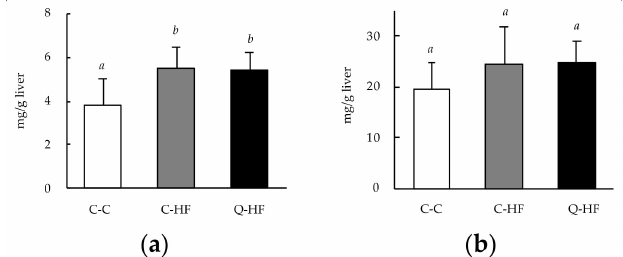
Figure 6. Effects of maternal quercetin consumption on hepatic total cholesterol and triglycerides. Male progeny of dams fed a control diet (C) or a diet containing 1.0% quercetin (Q) were divided into three groups: progeny of dams fed the C-diet that were also fed the C diet (C-C), progeny of dams fed the C-diet that were fed a 30% high-fat (HF) diet (C-HF), and progeny of dams fed Q-diet that were fed a HF diet (Q-HF). The animals were permitted free access to deionized water and the C-diet or HF-diet for 13 weeks, and then their hepatic levels of total cholesterol ( a ) and triglycerides ( b ). Data are shown as the mean ± SD ( n = 10). Different superscripts indicate significant differences ( p < 0.05). Different superscripts ( a , b ) indicate significant differences ( p <